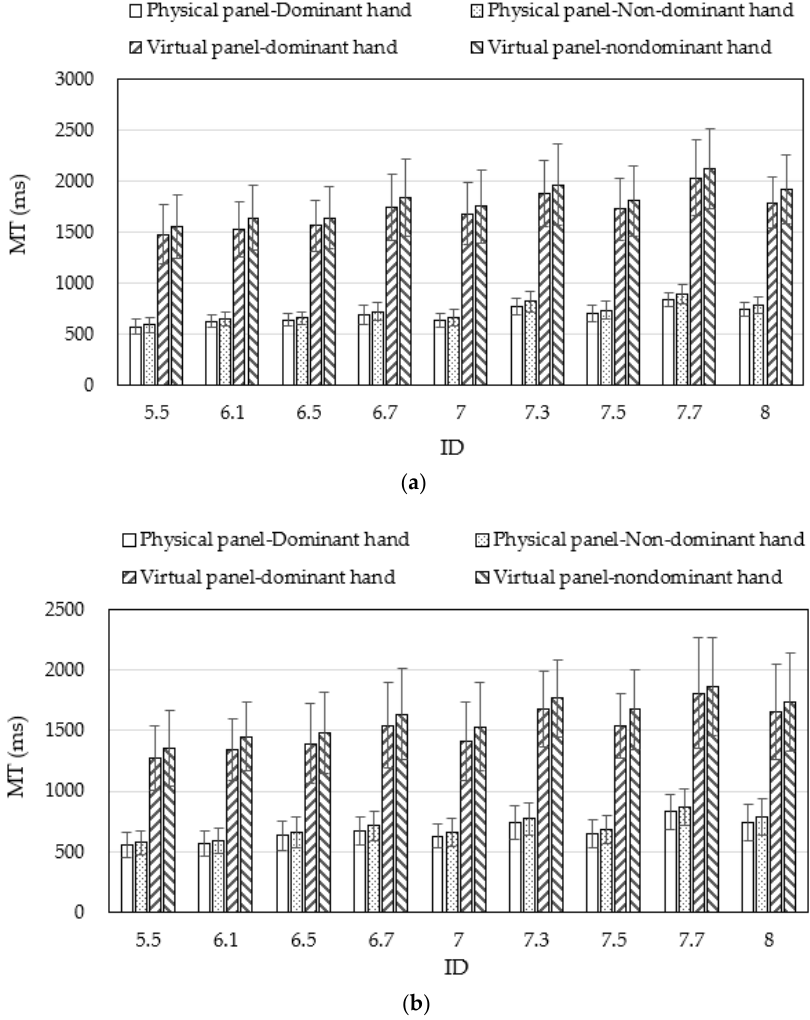
Figure 5. MT of female ( a ) and male ( b ) participants performing the horizontal pointing task. Table 3. Results of regression modeling of the